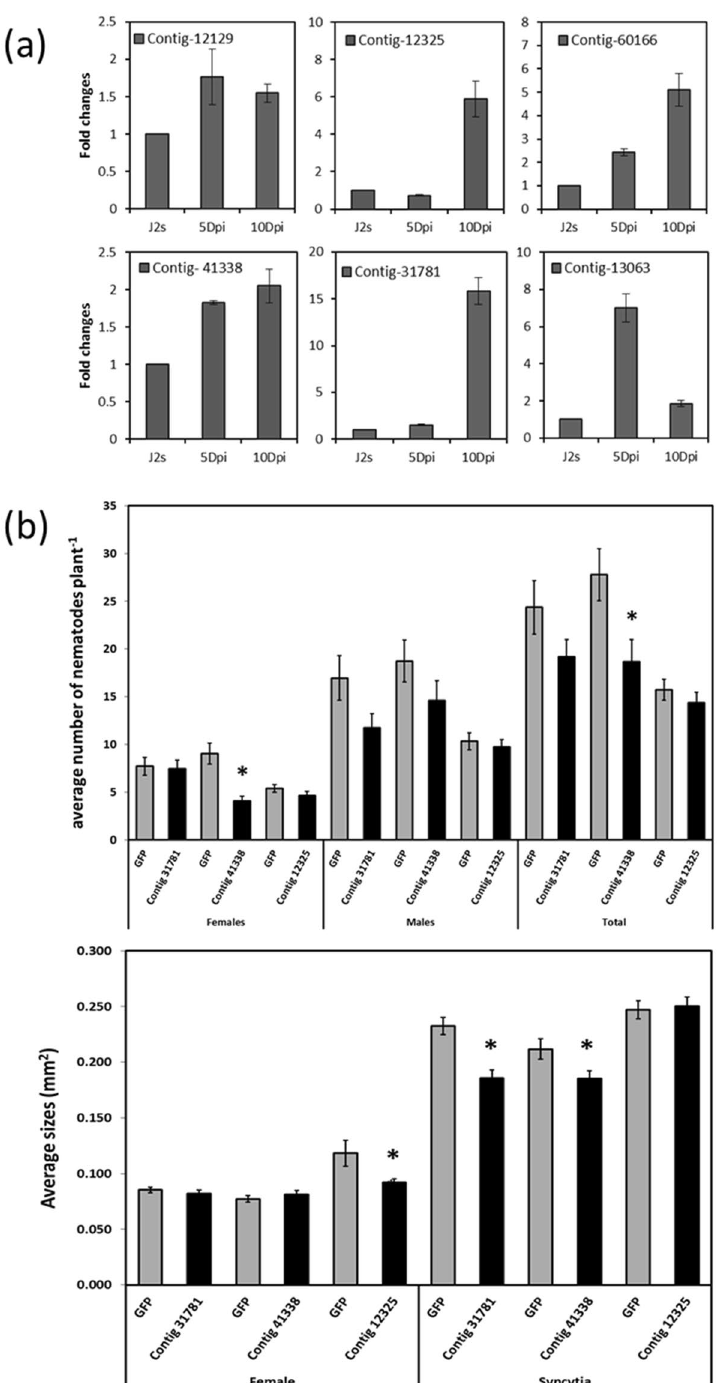
Figure 7. Experimental validation of a subset of Hs-EsoG-PSP. ( a ) qPCR, ( b ) RNAi, and each bar represents the mean ± standard error (n > 35). Asterisk indicates significant differences based on Student’s t -test (P <